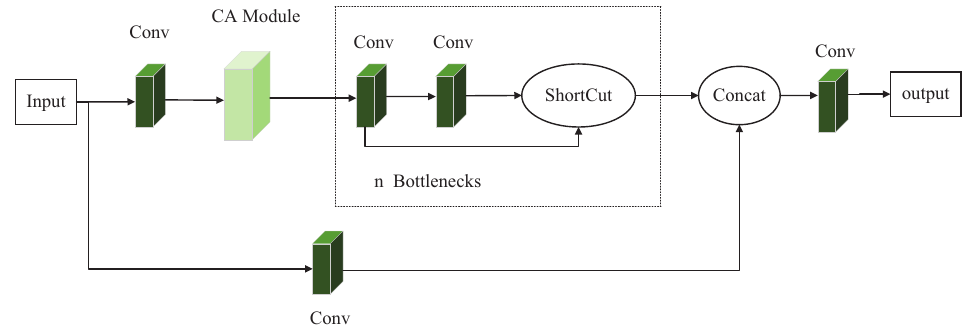
Figure 6. Schematic diagram of the C3-1 module.